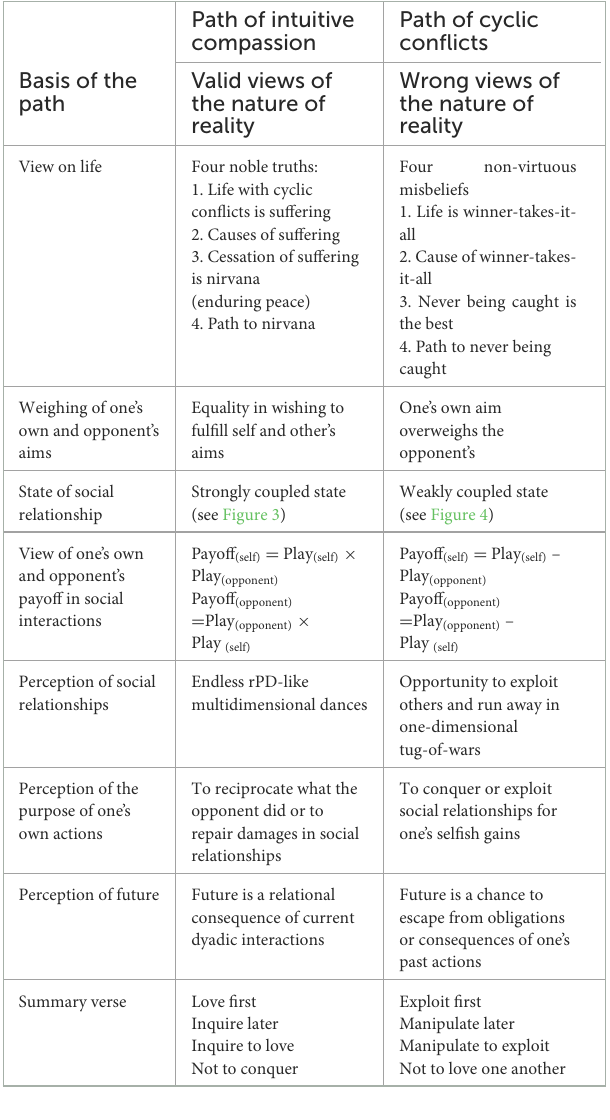
TABLE 4 Summary for two incompatible directions that bifurcate at each conflict as a stepping stone on the path of a dyadic relationship. Path of intuitive